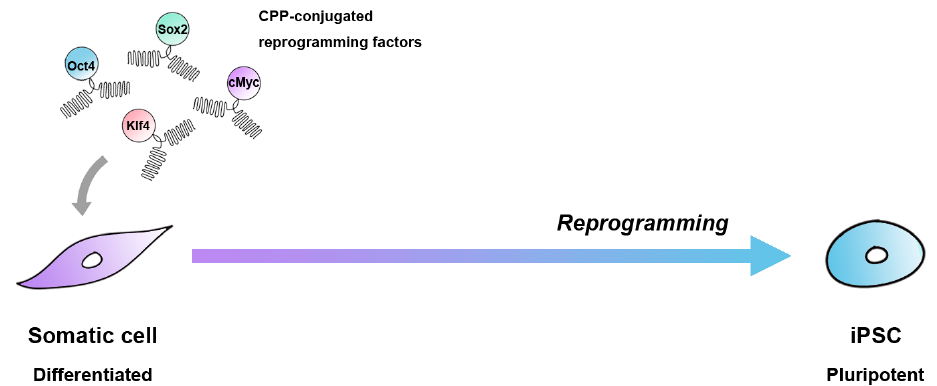
Figure 3. Reprogramming of somatic cells using CPP-conjugated proteins. Transduction of reprogramming proteins with a CPP may induce pluripotency in somatic cells. iPSC: Induced pluripotent stem